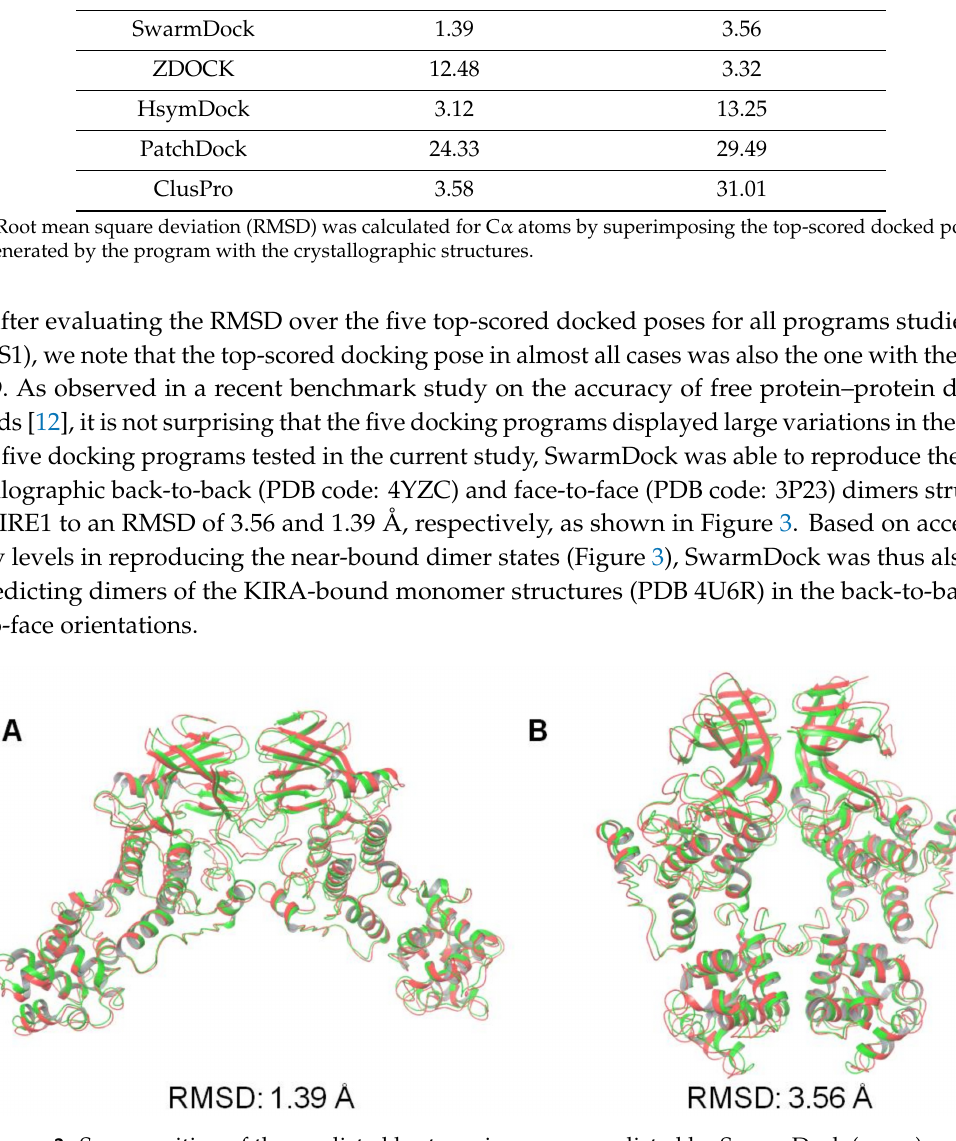
Figure 3. Superposition of the predicted best-scoring poses predicted by SwarmDock (green), onto the crystallographic dimer structures (red) of the IRE1 in ( A ) face-to-face (PDB code: 3P23) and ( B ) back-to-back (PDB code: 4YZC) conformations. The RMSD values based on the positions of the C α atoms relative to the crystallographic structures are